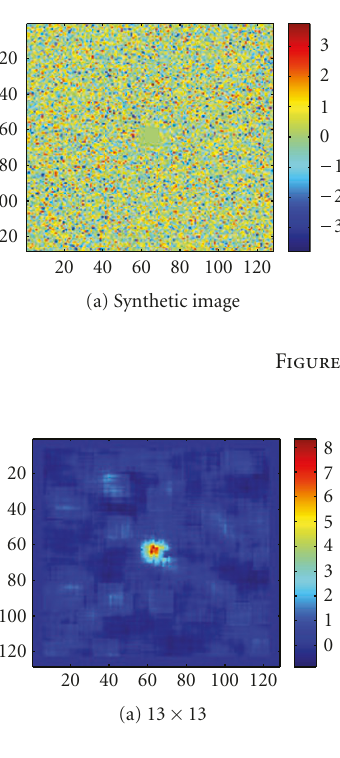
Figure 7: Kurtosis images obtained with di ff erent sizes of window (SNR = − 60 dB).